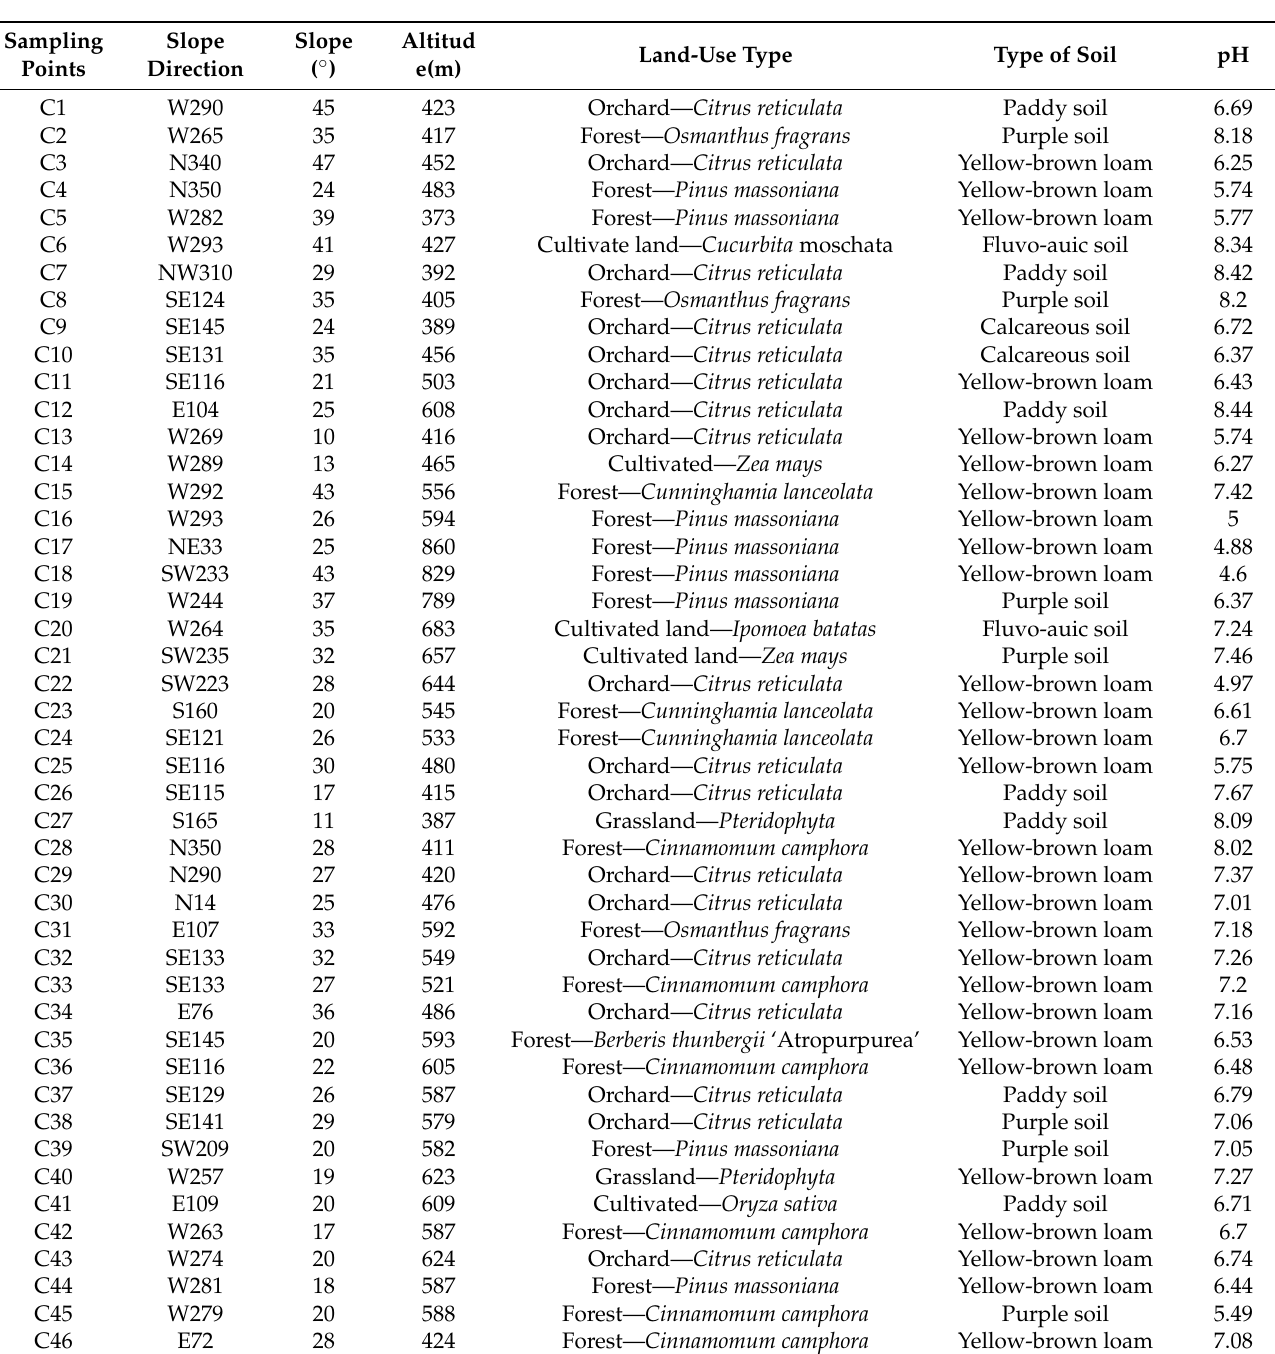
Table 1. Basic information on sampling